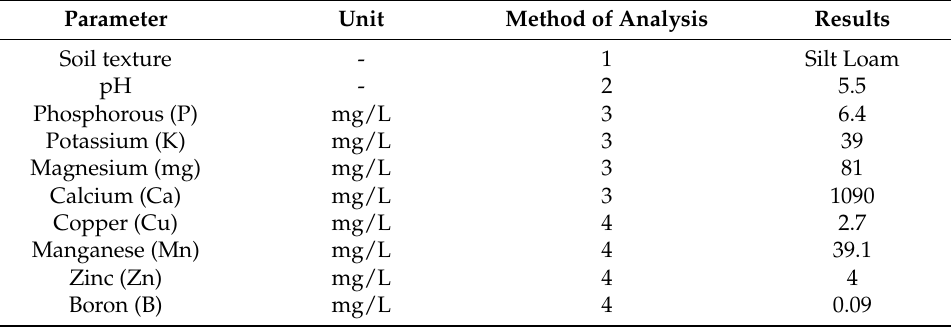
Figure 1. Field trial location in Ireland. Table 1. Initial trial area soil properties and soil texture.